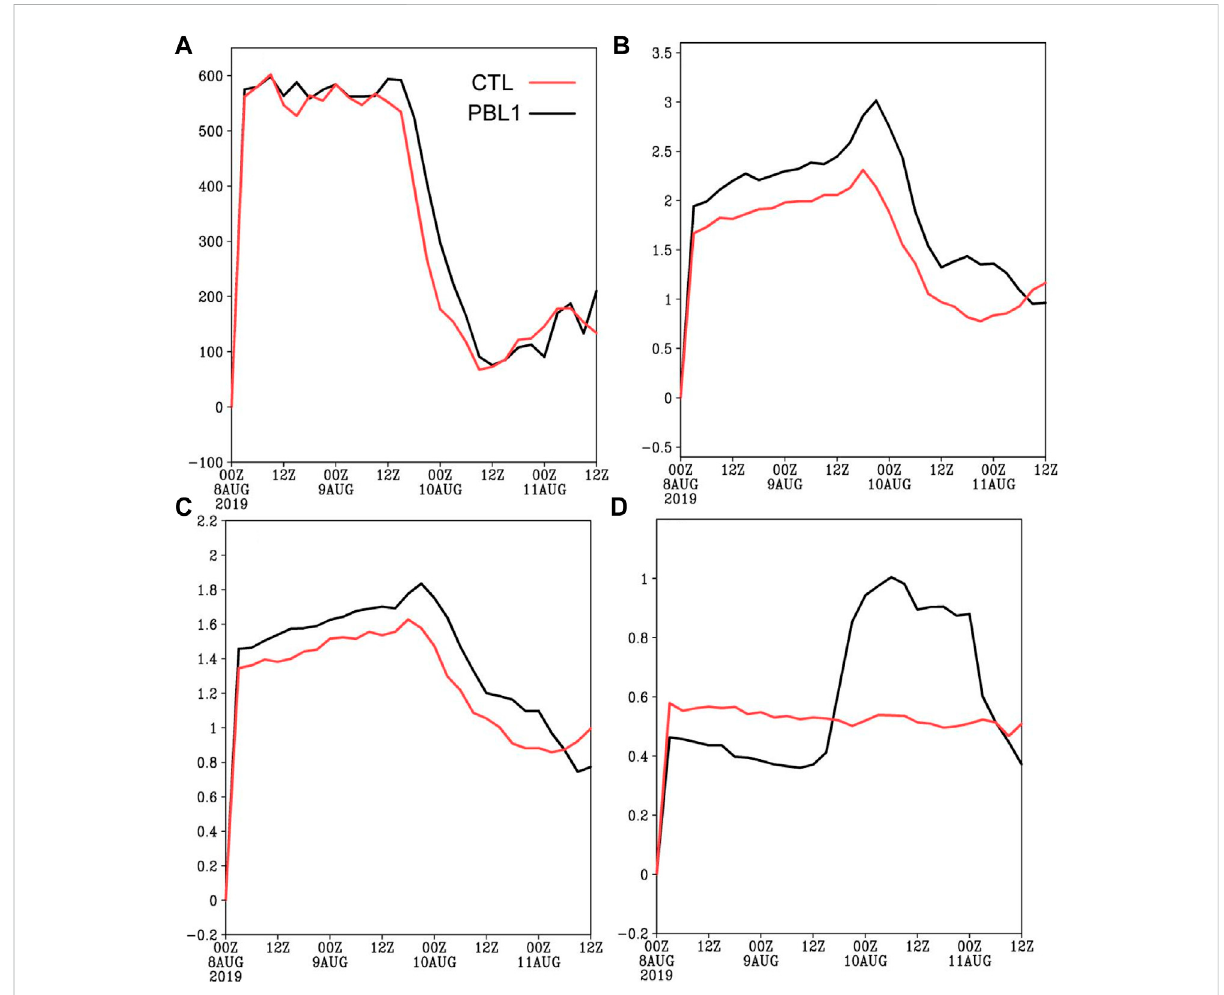
FIGURE 13 Time series of (A) surface latent heat fl ux (unit: W m − 2 ), (B) momentum fl ux (unit: kg m − 1 s − 2 ), (C) friction velocity (unit: m s − 1 ), and (D) boundary layer height (unit: km) within 200 km from the typhoon